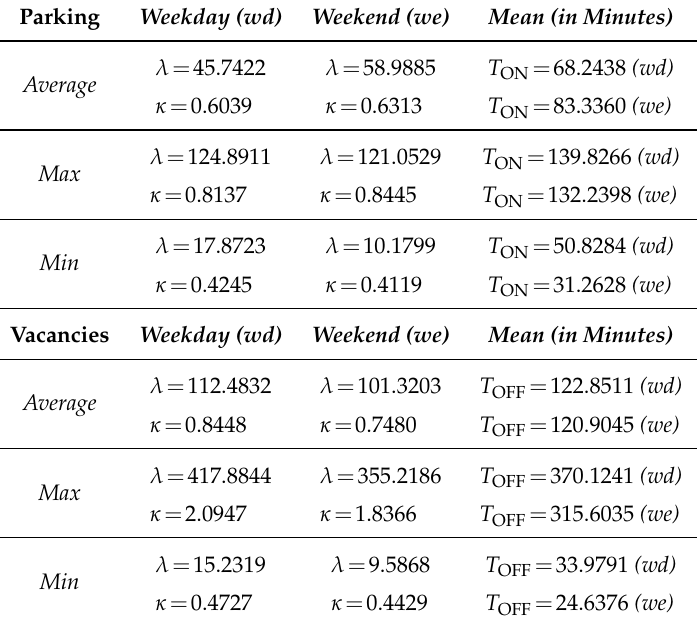
Table 1. Average, Max and Min values of the Weibull functions we fit on the